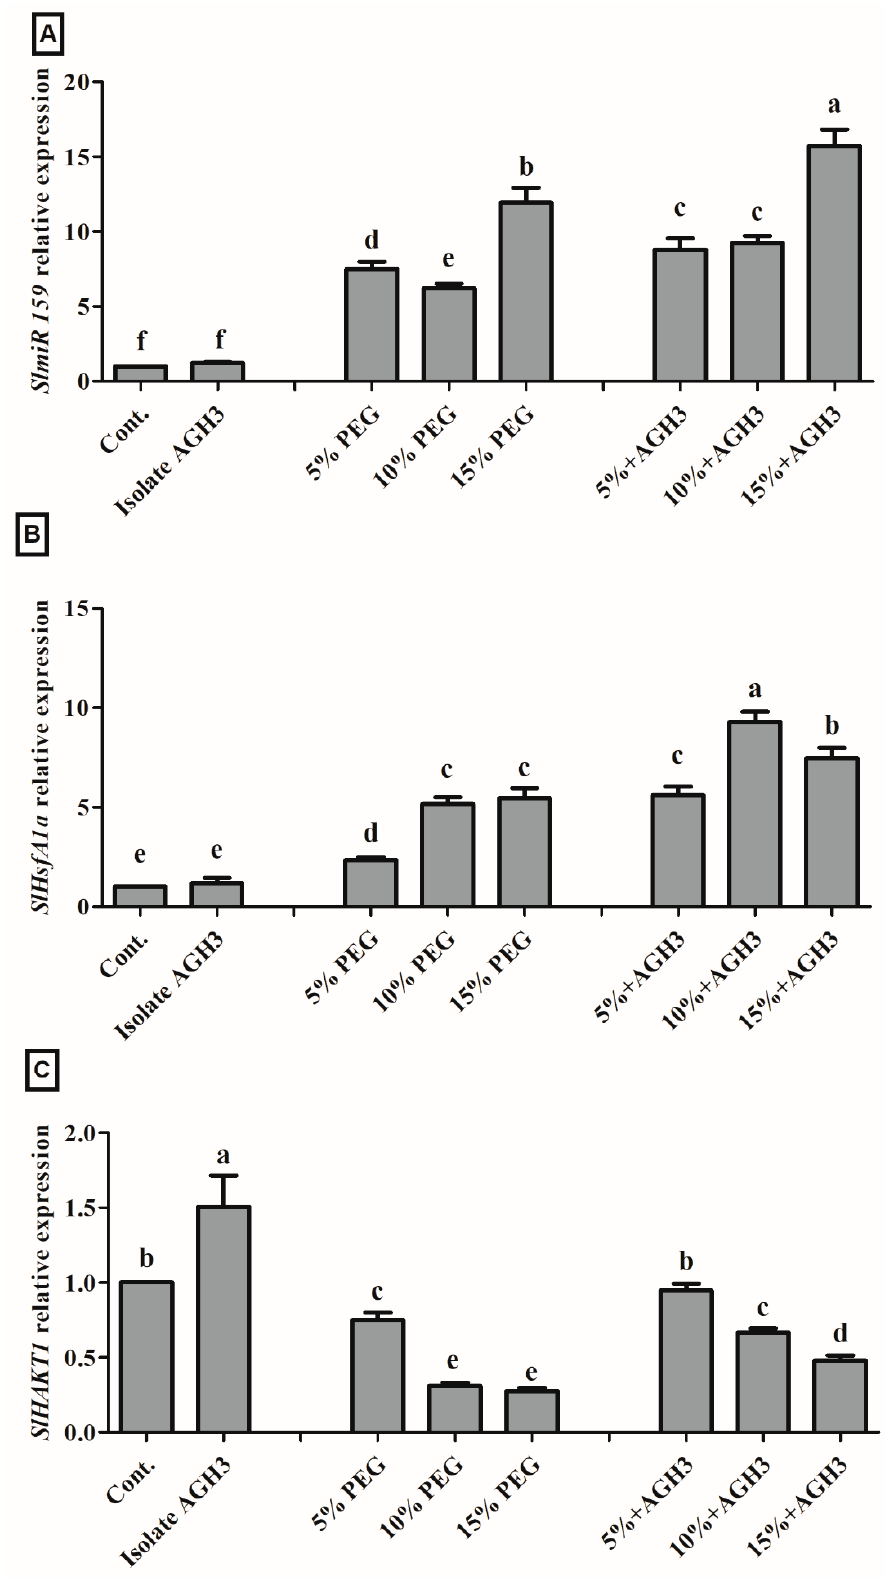
Figure 5. Gene expression of S. lycopersicum by using qRT-PCR under different PEG-stressed conditions with and without AGH3: ( A ) SlmiR159 ; ( B ) SlHsfA1a ; ( C ) SlHAKT1. Different letters in the column show that values are significantly different ( p < 0.05) from each other as evaluated from the DMRT